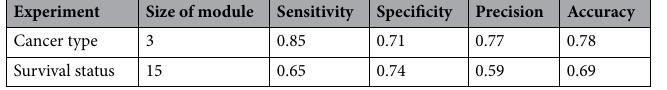
Table 4. Performance of the detected module.